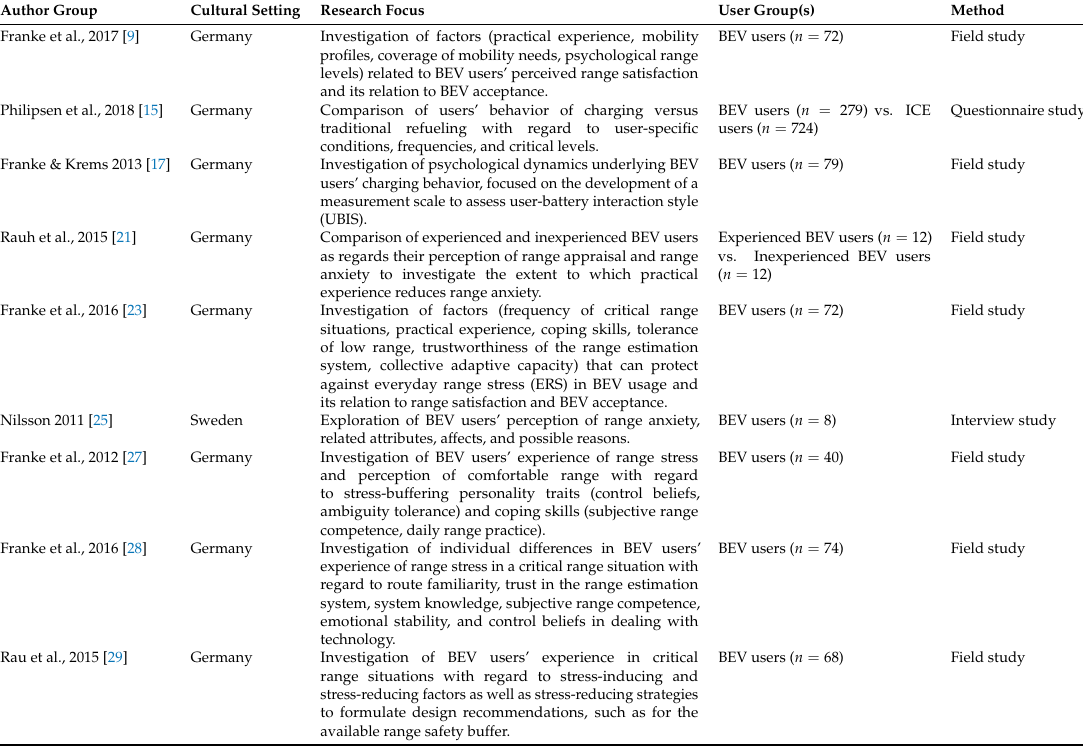
Table A1. Overview of existing relevant literature on range stress with details on research focus and